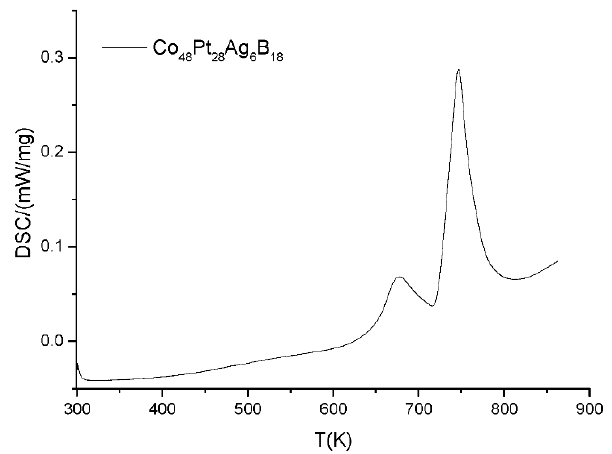
Figure 1. DSC curve for as-cast Co 48 Pt 28 Ag 6 B 18 alloy at 10 K/min.